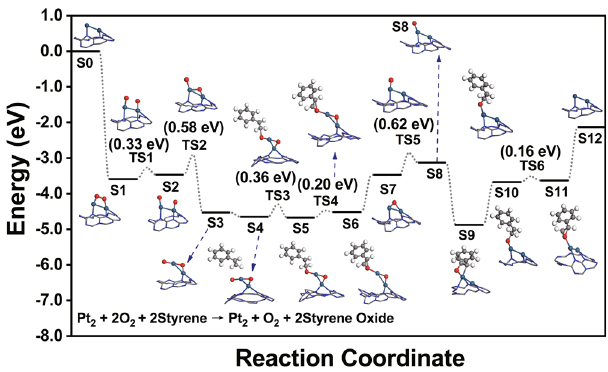
Fig. 7 First-principles calculations of styrene epoxidation on Pt 2 /g-C 3 N 4 . Reaction pathway and computational energy pro fi le of styrene epoxidation on the Pt 2 /g-C 3 N 4 catalyst. The label S0 represents the initial state and the subsequent labels S1 – S11 represent a series of intermediate states. The labels TS1 – TS6 (TS is short for transition states) represent a series of transition states. Here, only the key structures, i.e., the Pt 2 catalytic system as well as the adsorbate bound on it, are shown. The information regarding reactant molecules which have not been adsorbed, and/or product molecules which have been desorbed are labeled in the Supplementary Information (Supplementary Fig. 32). The teal, gray, blue, red, and white spheres represent the Pt, C, N, O, and H atoms,